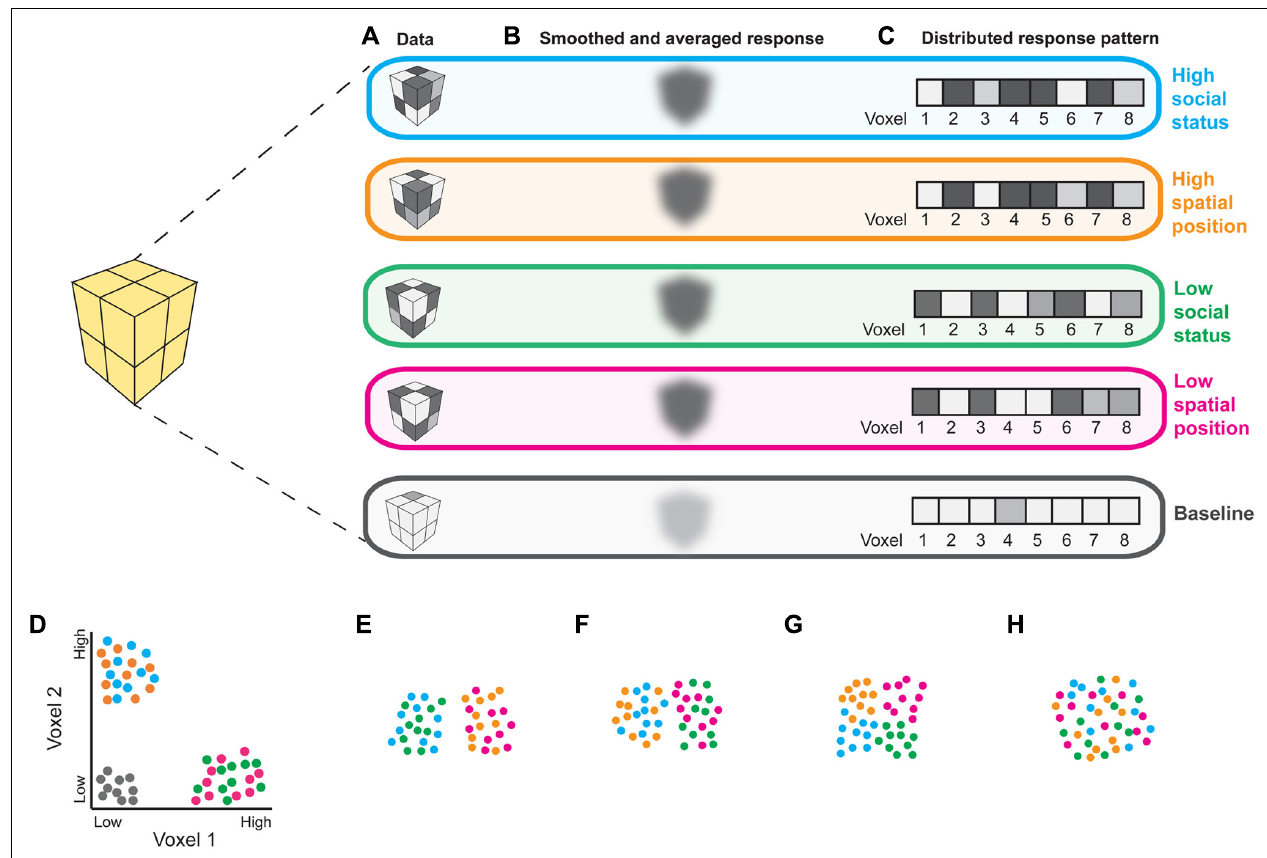
FIGURE 1 | Interpreting fMRI responses to social and spatial tasks. (A) Hypothetical responses from an 8-voxel region of interest (ROI) to stimuli depicting: high social status (blue), high spatial position (orange), low social status (green), and low spatial position (pink), as well as baseline (gray; fixation cross). (B) Comparing the magnitude of locally smoothed and averaged responses could reveal that this ROI responds robustly to all 4 conditions relative to baseline, suggesting that it is involved in both social and spatial processing. (C) The same data can be studied as multivoxel patterns; responses from an ROI containing n voxels can be analyzed as n -dimensional vectors. Examining response patterns using MVPA can reveal more detailed information regarding the representational content of an ROI, as illustrated in (D–H) . (D) Responses from voxels 1 and 2 from the patterns depicted in (C) for 10 examples of each stimulus category; two-dimensional patterns are presented for clarity of visualization. Each dot represents a response to an example of each experimental condition. Experimental conditions are indicated by dot color. Machine learning algorithms can be used to determine which distinctions a region contains information about (Norman etal.,